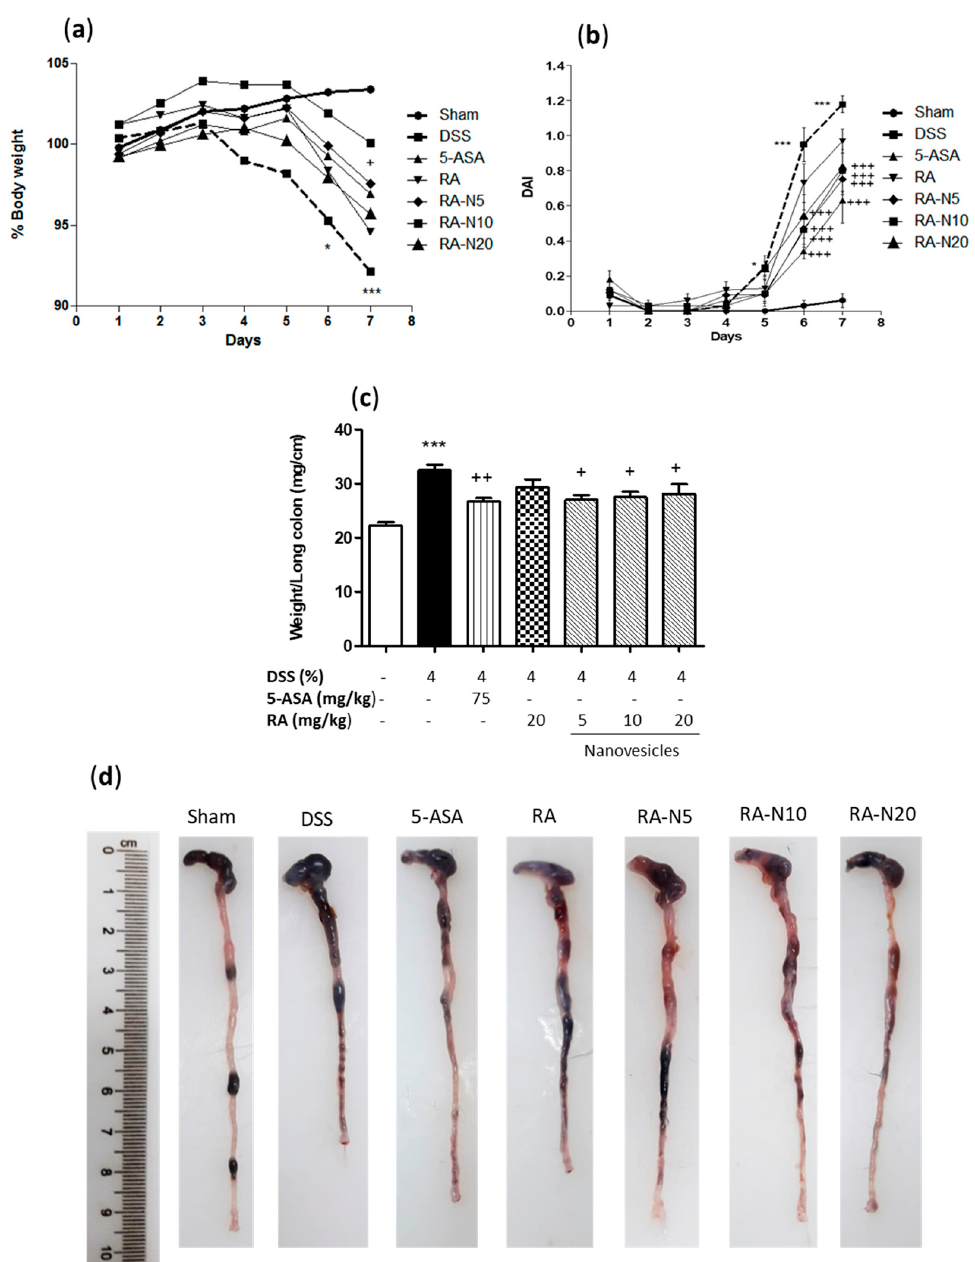
Figure 2. ( a ) Effects of rosmarinic acid (RA)-loaded nanovesicles (5, 10 and 20 mg/kg), RA (20 mg/kg) or aminosalicylic acid (5-ASA) (75 mg/kg) on body weight development in dextran sodium sulphate (DSS)-induced colitis in mice. Body weights were normalised against body weight on day –1. ( b ) Disease activity index (DAI) was determined as the average of the scores of bleeding, weight loss, and stool consistency. ( c ) Weight/length ratio of the colons. ( d ) Representative images of colons from all groups. Data are exhibited as the mean ± SEM. Mean value was significantly different compared with the sham group (* p < 0.05, *** p < 0.001; Student t test). Mean value was significantly different compared with DSS group (+ p < 0.05, ++ p < 0.01, +++ p < 0.01; one-way ANOVA followed by Bonferroni’s Multiple Comparison test).